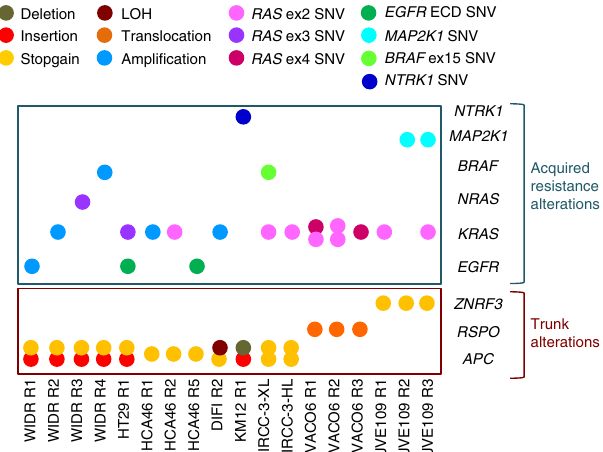
Fig. 1 Heterogeneous mechanisms of secondary resistance to targeted therapies in colorectal cancer (CRC) cells. Indicated CRC cells were made resistant to single targeted agents or combination of them (see Supplementary Table 1). Trunk alterations in the WNT pathway are depicted in the lower brown box. The upper blue box illustrates multiple, often co-occurring, genetic alterations acquired at secondary resistance. SNV indicates Single Nucleotide Variance. Ex stands for exon. ECD stands for extra-cellular